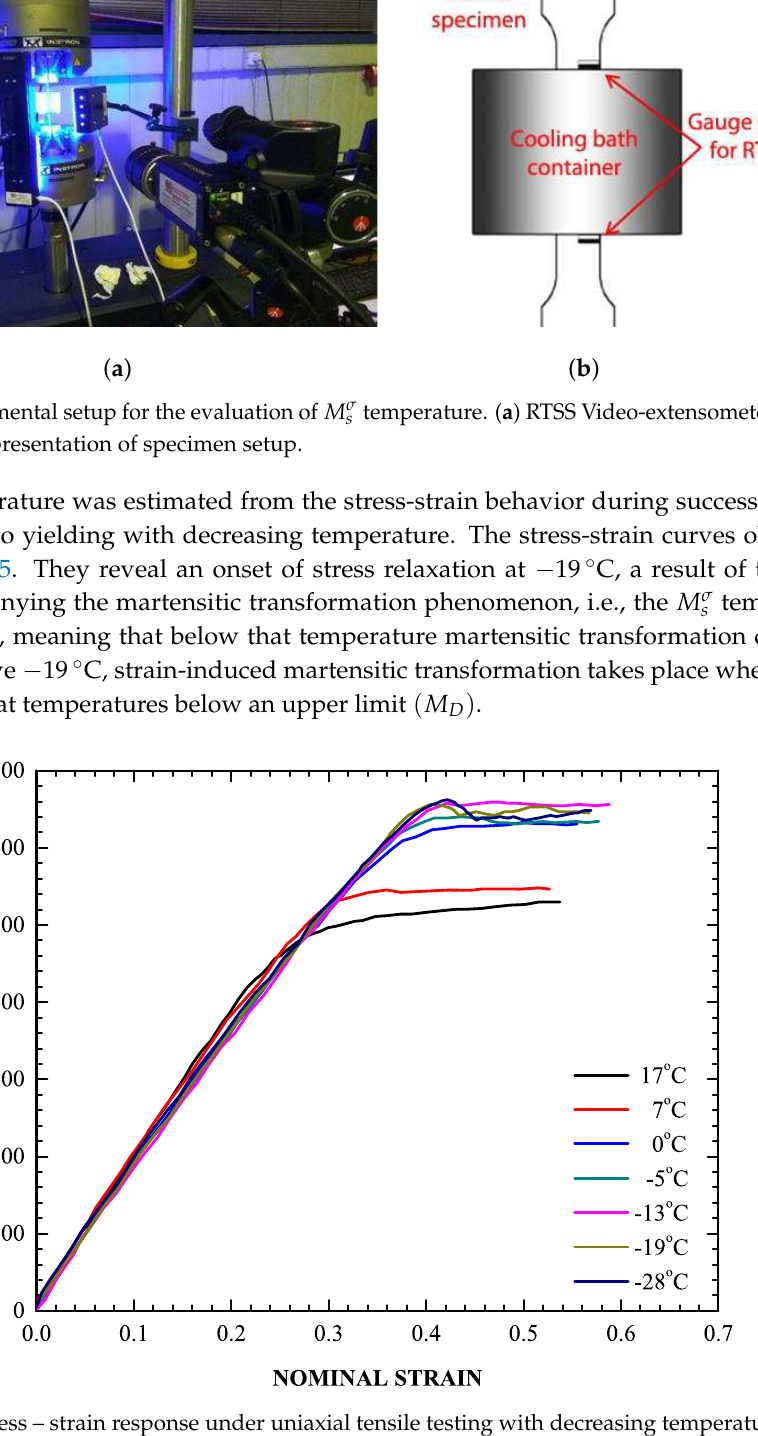
Figure 5. Stress – strain response under uniaxial tensile testing with decreasing